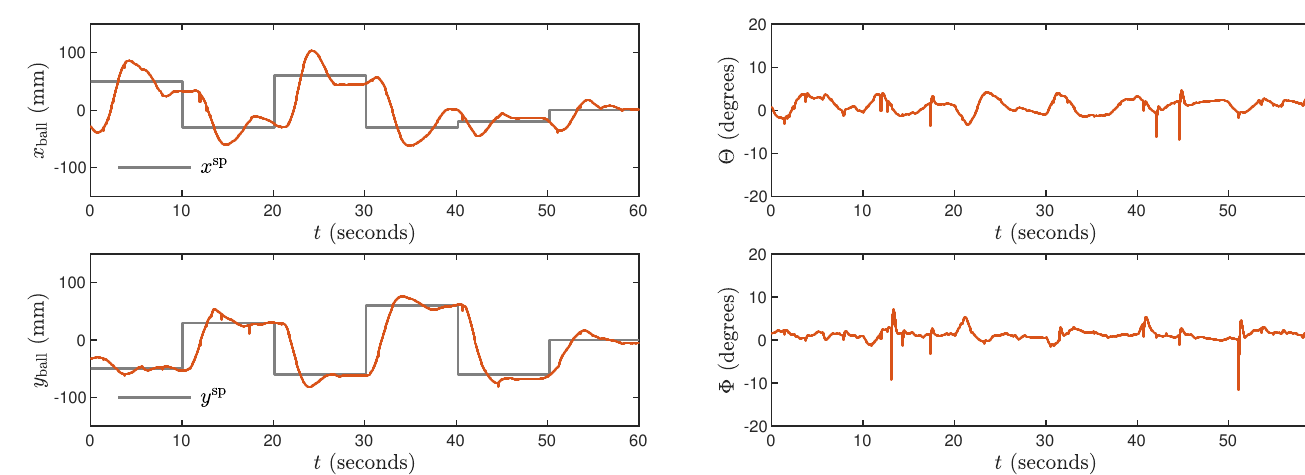
Figure 4. Experimental results of the MPC2